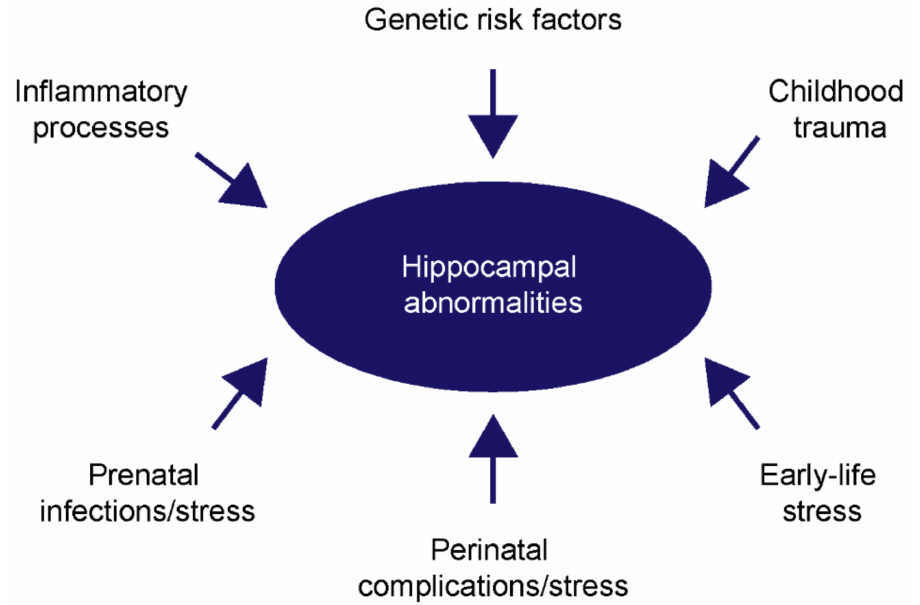
Figure 3. The possible risk factors for hippocampal deviations in schizophrenia. Besides genetic factors that increase the risk for hippocampal alterations, several environmental factors have been identified that directly influence hippocampal integrity. Here, especially prenatal, perinatal and early-life stress have negative effects regarding structural, as well as functional properties of the hippocampus. Furthermore, childhood trauma and inflammatory processes can negatively affect the development and the